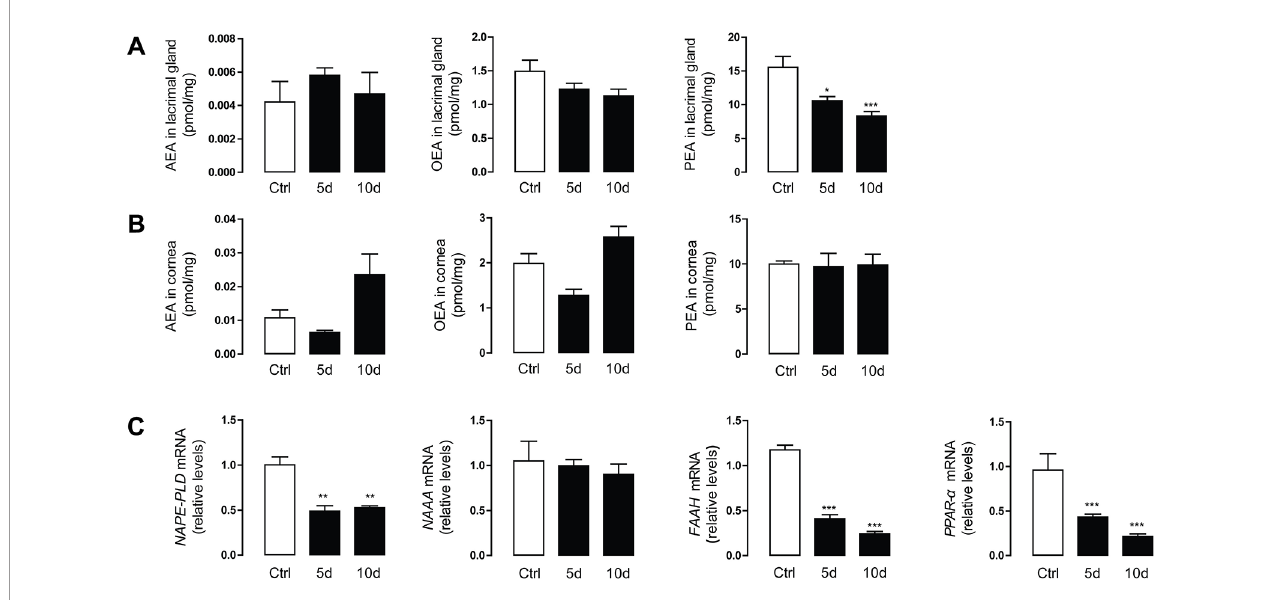
FIGURE 1 | Sleep deprivation (SD) reduced the lacrimal gland (LG) levels of palmitoylethanolamide (PEA). Levels of anandamide (AEA), oleoylethanolamide (OEA), and PEA in LG tissue (A) and corneal tissue (B) . Control group (Ctrl, open bars), SD-induced mice model for 5 and 10 days (5d, and 10d, respectively, solid bars). Bottom panel showed the mRNA expression levels of FAE metabolic enzymes and peroxisome proliferator-activated receptor- a (PPAR- a ) in LG tissue (C) . *, P < 0.05; **, P < 0.01; ***, P < 0.001 vs. control; unpaired t -test, n = 5.